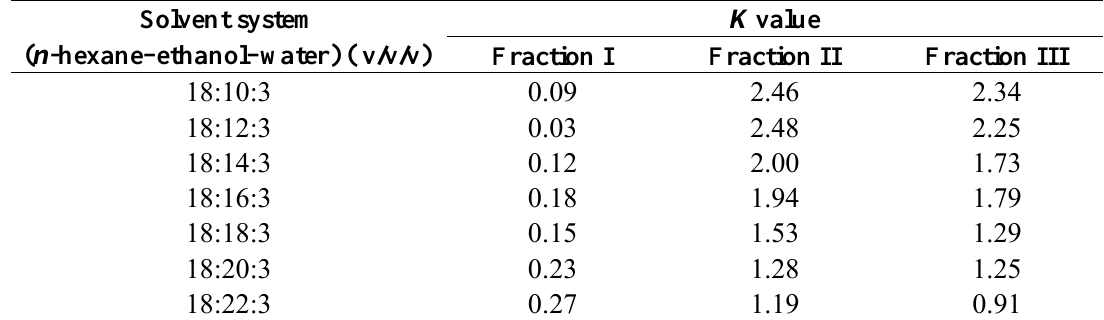
Table 1. K values of the target compounds in several two-phase solvent systems.